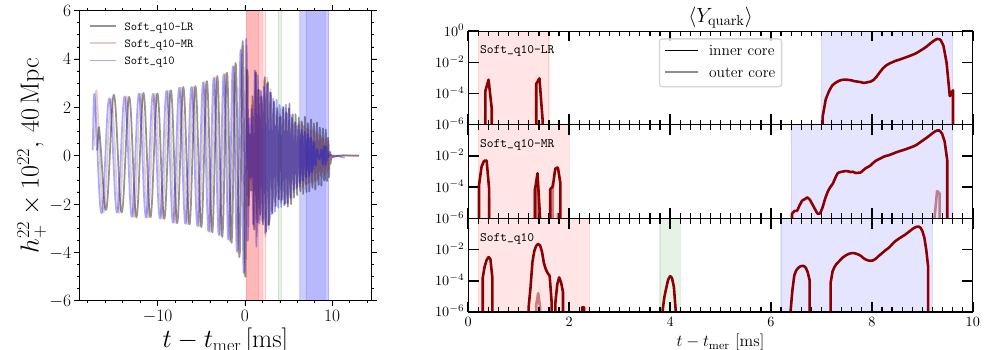
Figure 6: Shown are the consistency results of the Soft_q10 dataset. Left: consis- tency as measured in the gravitational wave strain h 22 polarisation amplitude. Al- + though slight changes in the amplitude and phase are observed, the collapse time is the same in all resolutions. Right: the corresponding quark fraction for the three res- olutions considered. Most notable is the appearance of WQ in the high-resolution run further emphasising the need for high resolutions to capture fine-structure